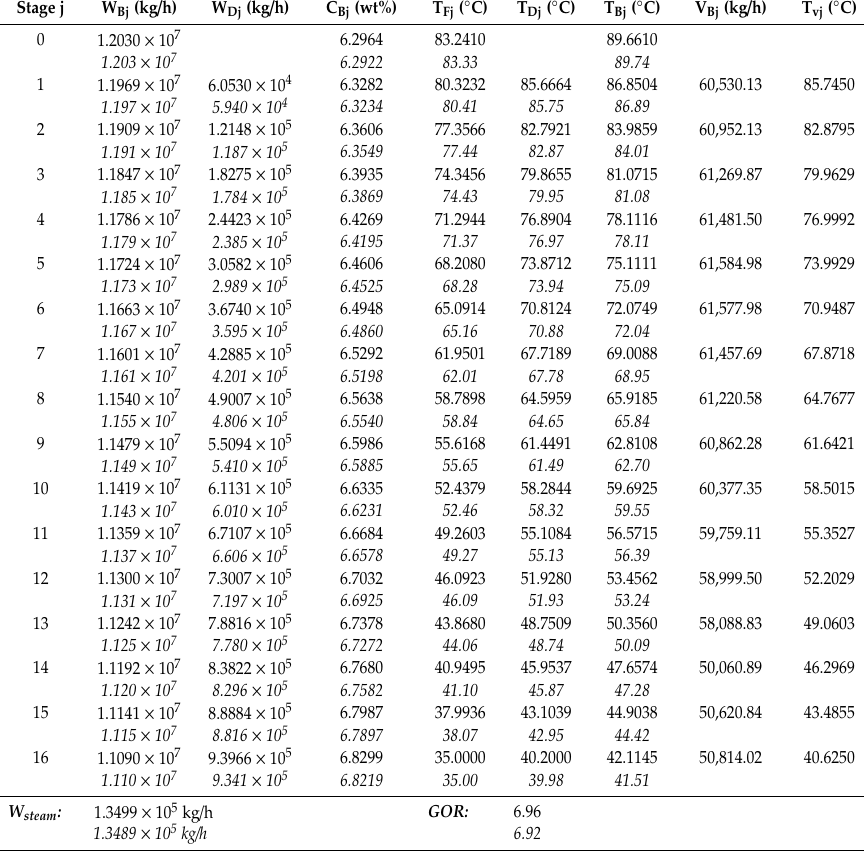
Table 3. Simulation